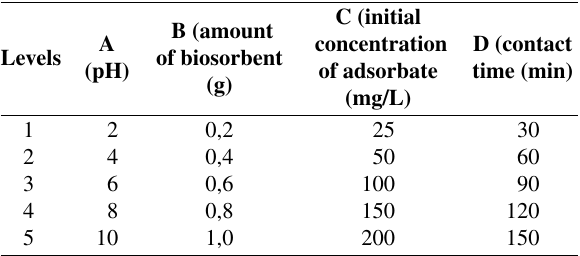
Table 1. Factors and levels for experimental parameters used to in sorption capacity test C (initial B (amount concentration Levels of biosorbent